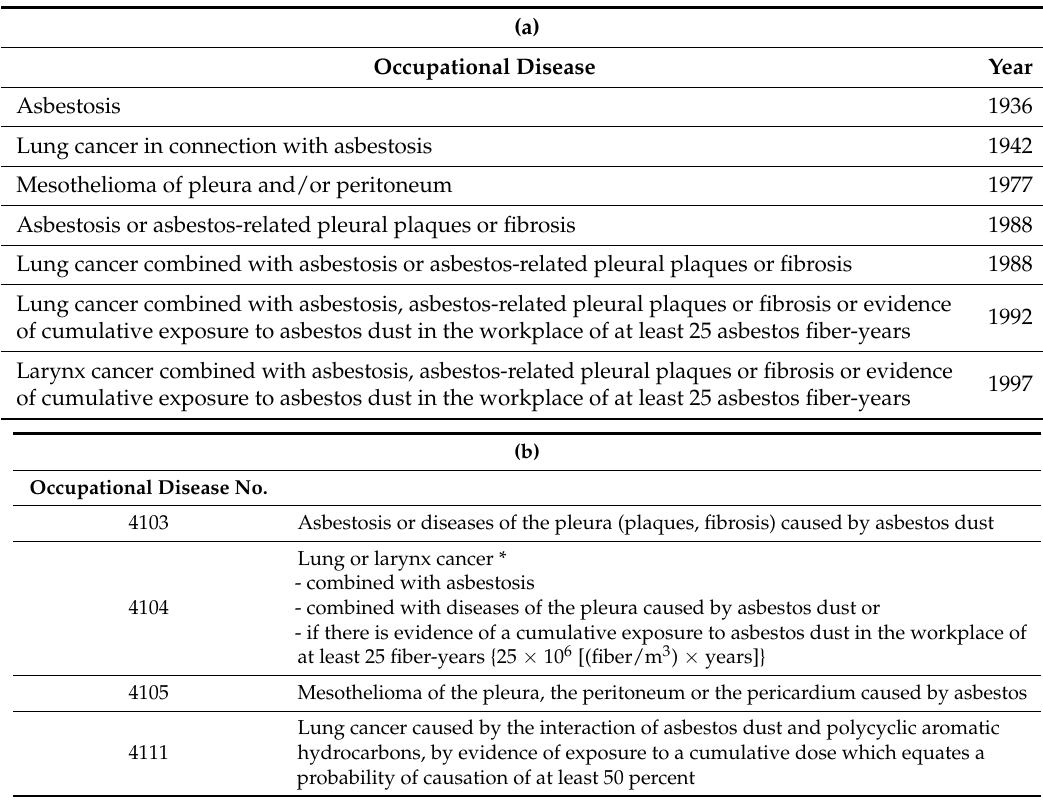
Table 3. ( a ) Introduction of asbestos-related disorders in the list of German occupational